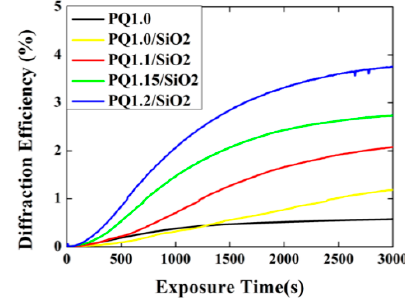
Figure 5. The dependence of the orthogonal linearly-grating diffraction efficiency on exposure time.